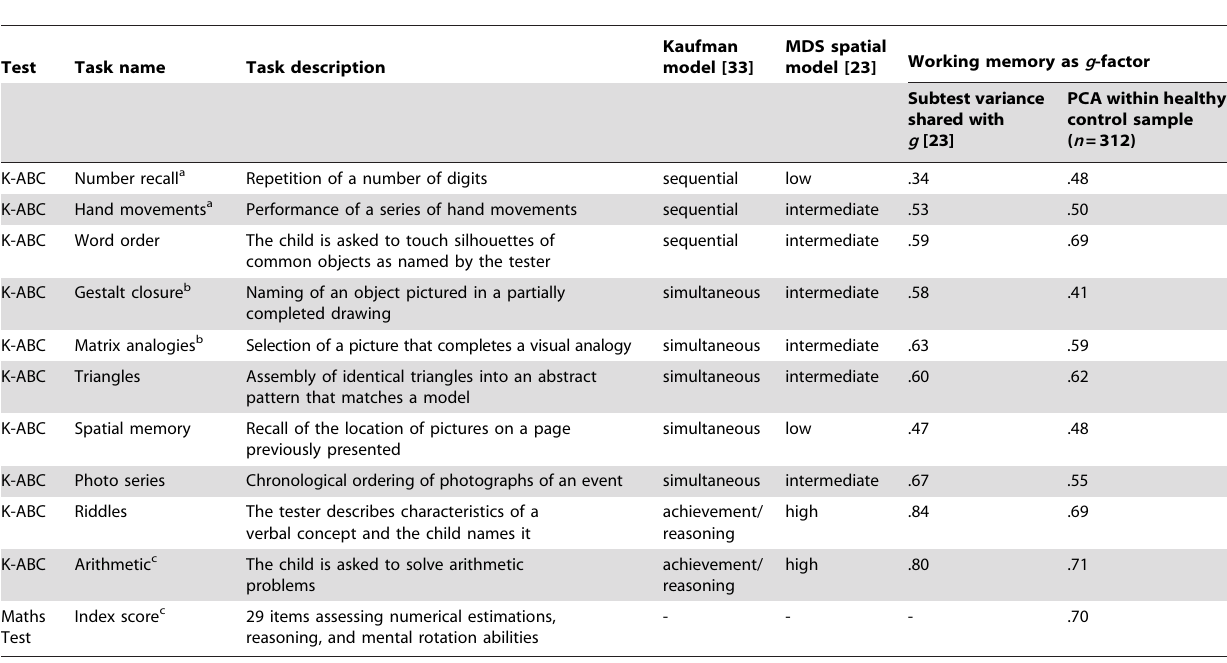
Table 2. K-ABC subtests’ and Mathematic Test’s cognitive workloads according to different